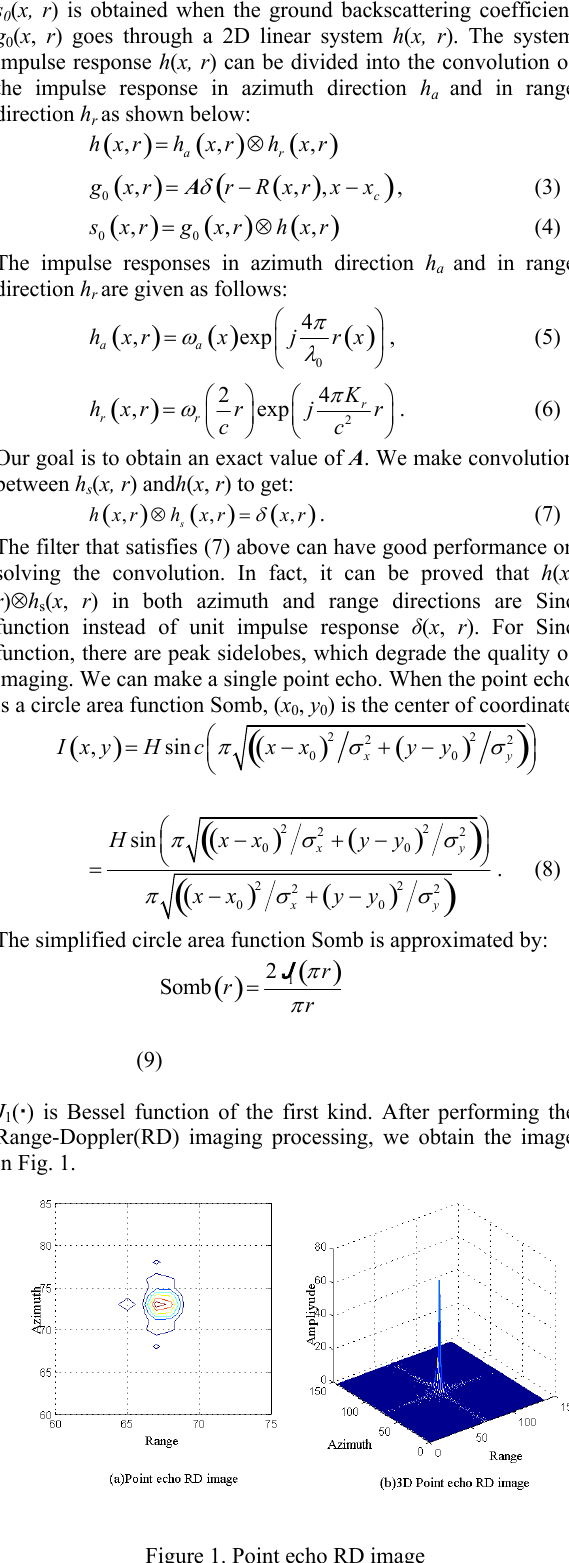
Figure 1. Point echo RD